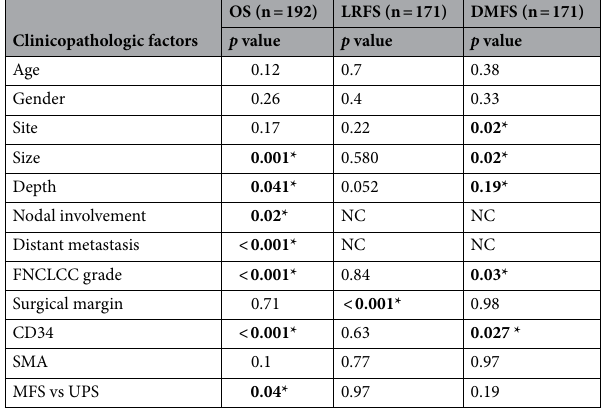
Table 3. Univariate analysis of clinico-pathologic factors with potential to affect overall survival (OS), local- recurrence free survival (LRFS), and distant-metastasis free survival (DMFS). Bold values indicate p < 0.05 * p < 0.05. NC not calculated.